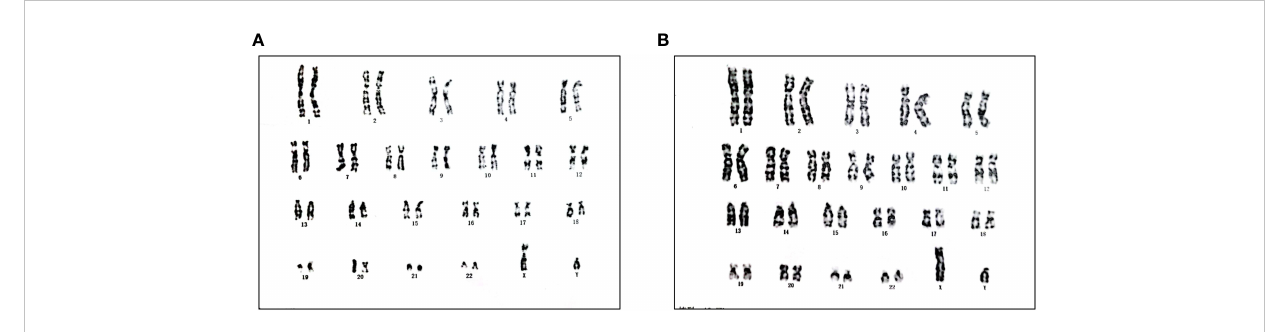
FIGURE 1 Karyotype of III:1 (A) and III:2 (B)